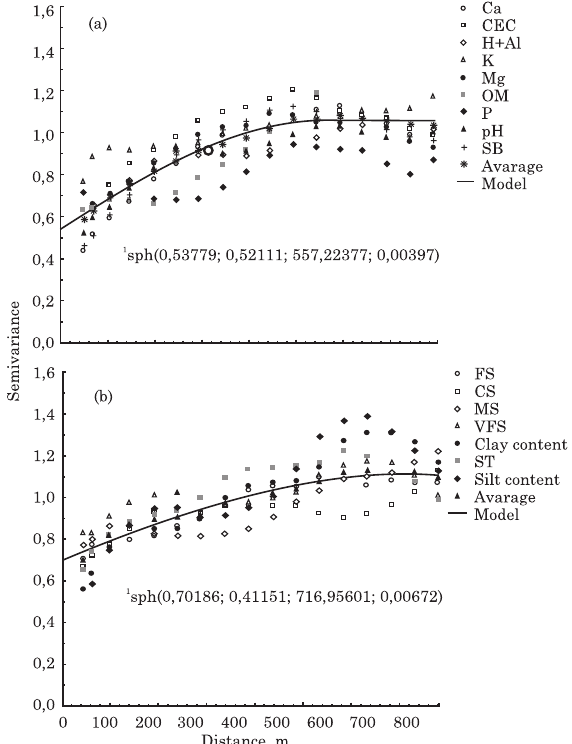
Figure 2. Scaled experimental variogram for the chemical (a) and physical (b) properties. (1) ( ), model ( C 0 ; C 1 ; a ; MSE